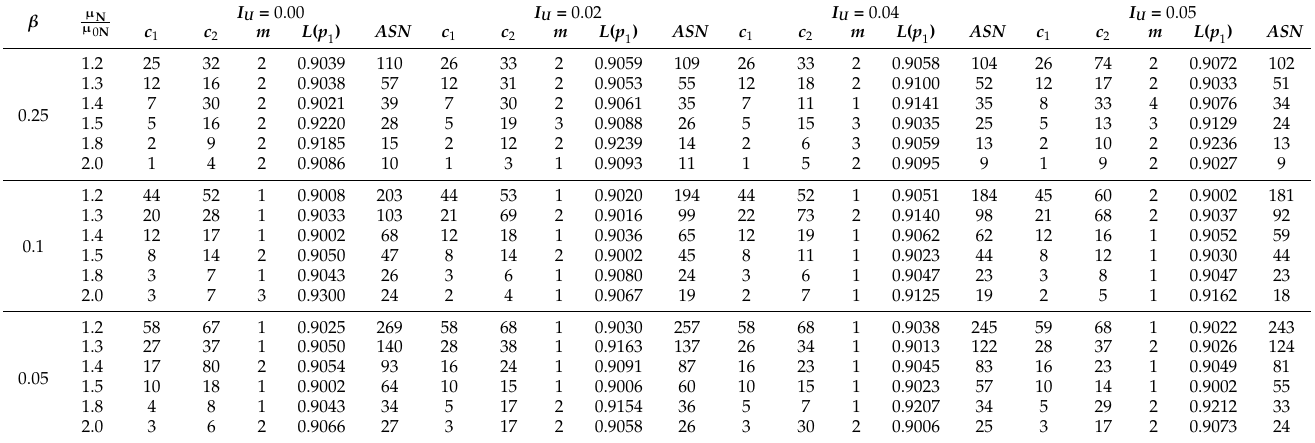
Table 1. The MDS design values for α = 0.10, ν = 2.0, and a = 0.5.